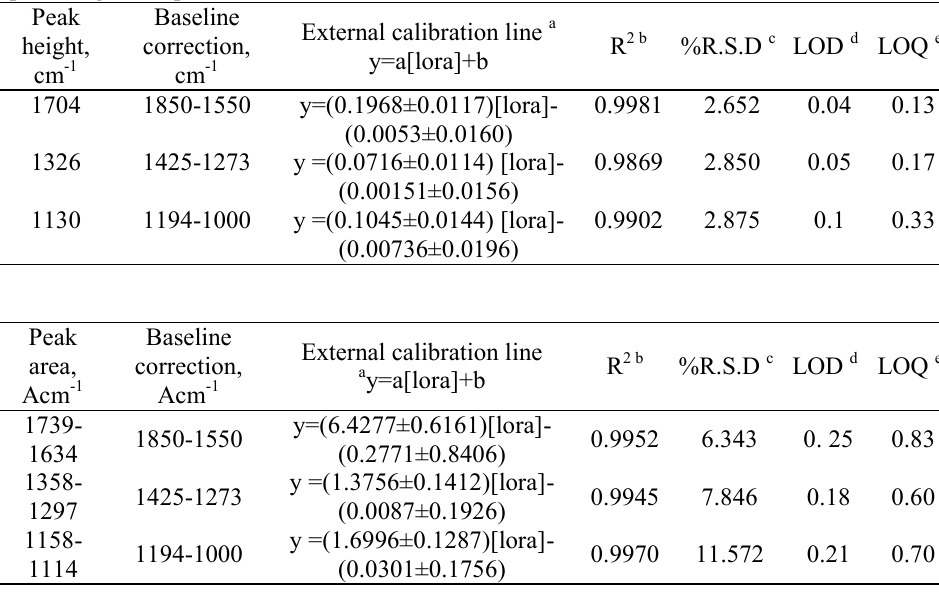
Table 1. Analytical features of FTIR determination of lorazepam in pharmaceuticals using peak height and peak area with different baseline